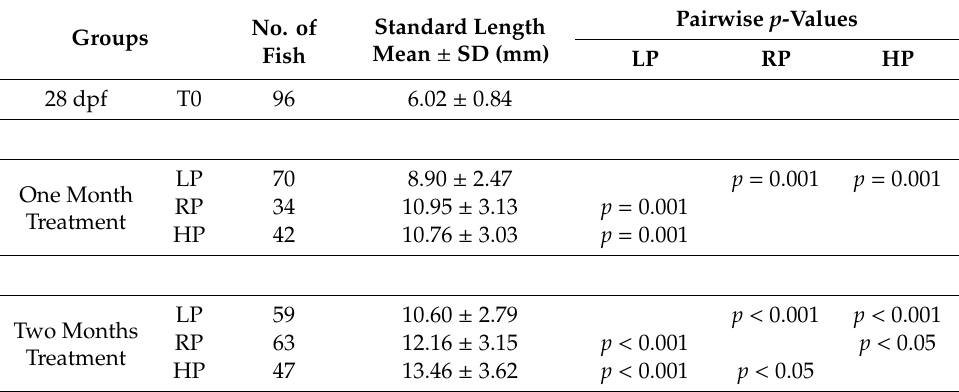
Table 1. Standard length